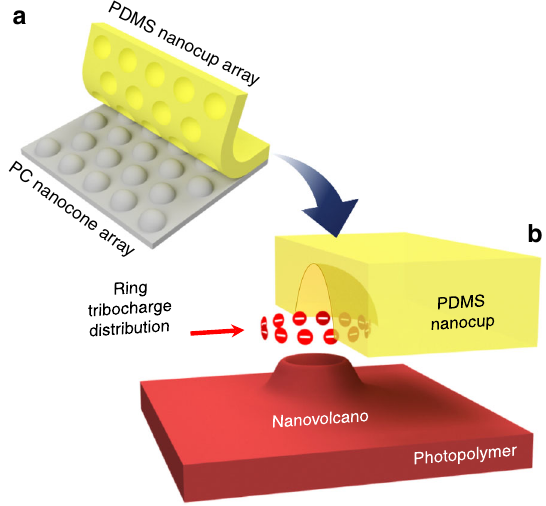
Fig. 1 Replica molding-based tribocharging and its use in EHDL. a After being replica molded from a nanotextured polycarbonate (PC) mold,